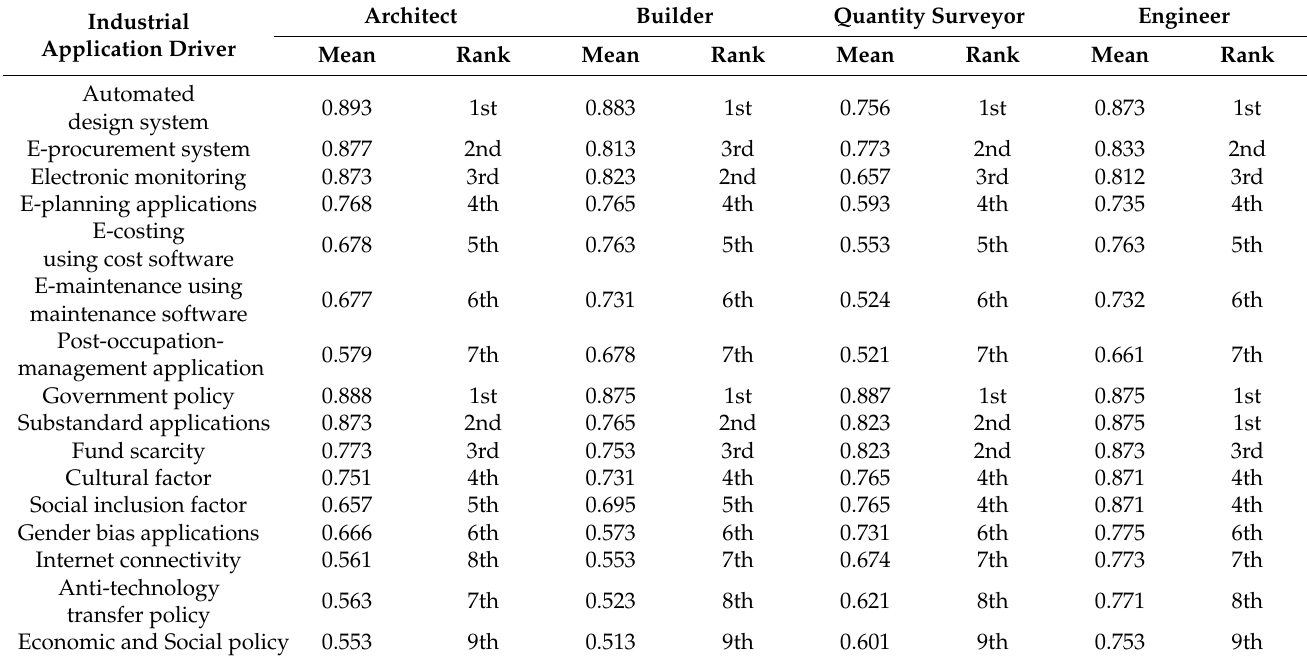
Table 3. Industrial Application Drivers of I4.0 and C4.0 that are important in Achieving C4.0 from Professionals’